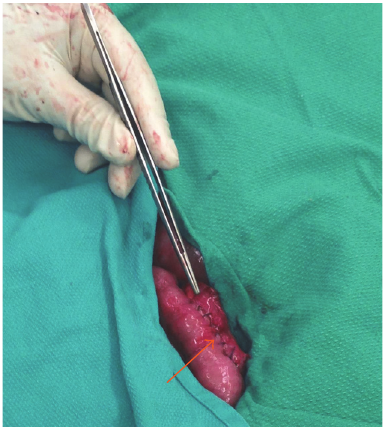
Figure 11: Completed duodenojejunostomy (jejunum, orange arrow) (Case Report